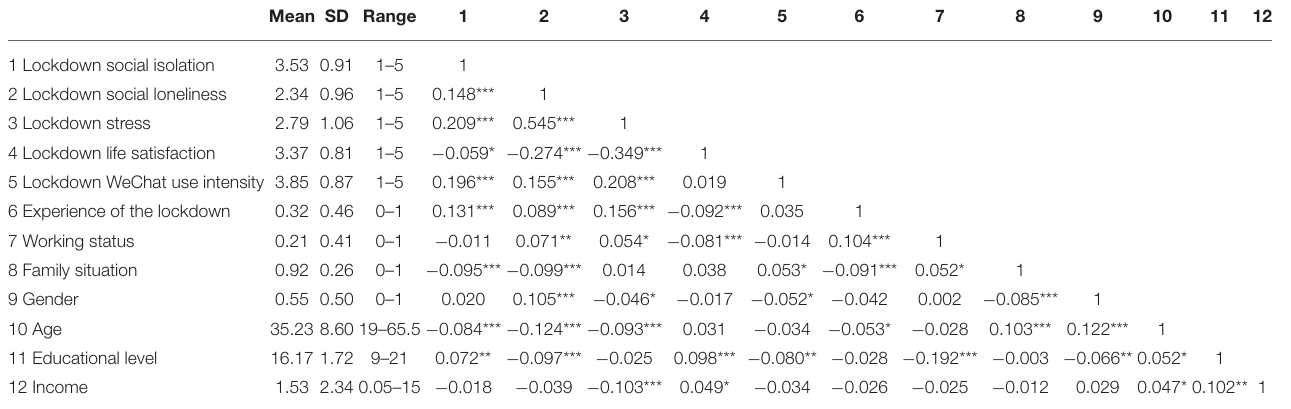
TABLE 3 | Mean, standard deviations, and correlations matrix for the whole